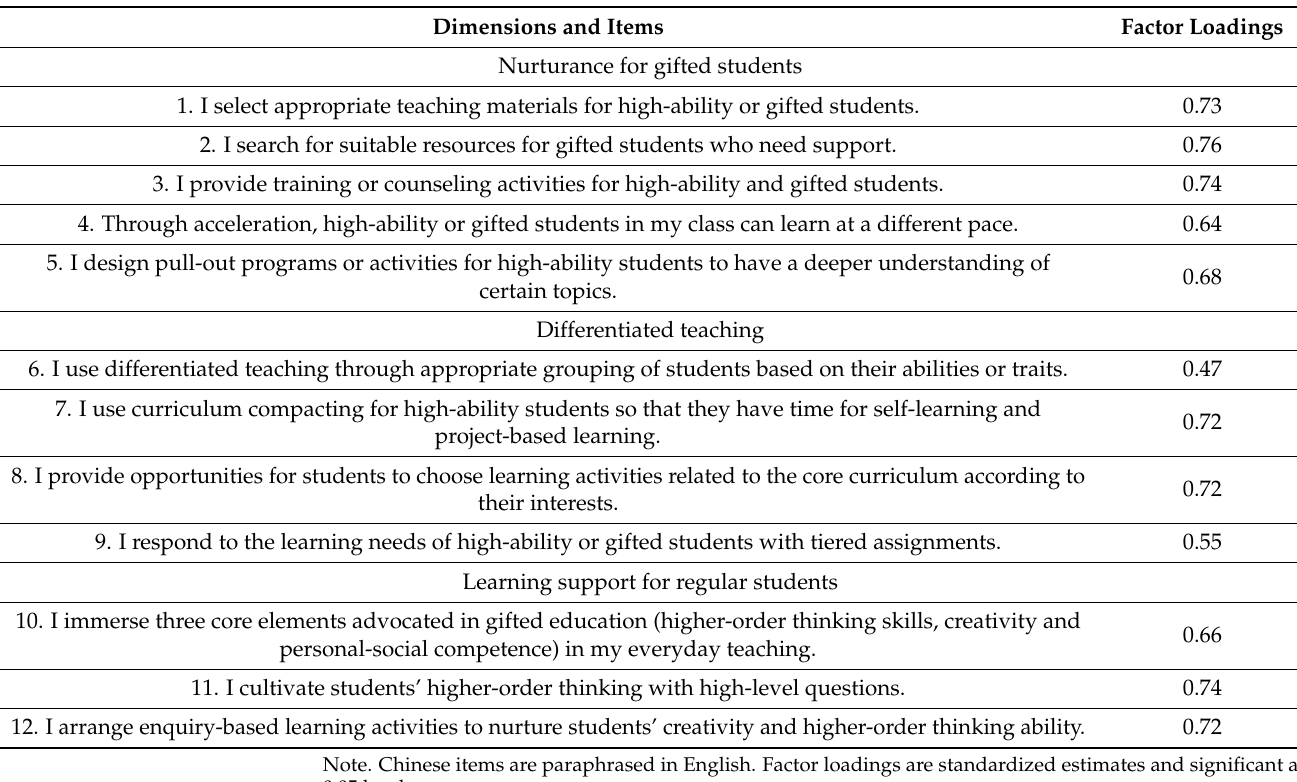
Table 5. Factor loadings of the12 items of the Teacher Behavior Scale at pretest of the matched sample. Dimensions and